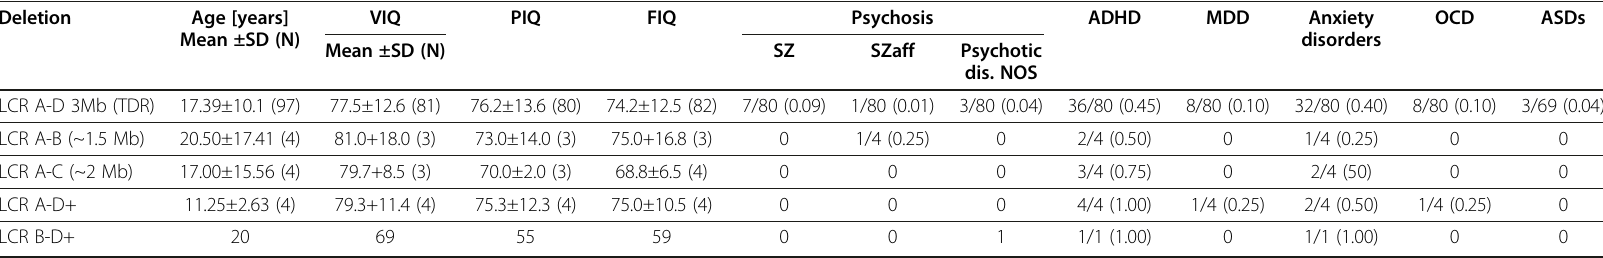
Table 2 Clinical data for 22q11.2DS subjects - Psychiatric and cognitive features